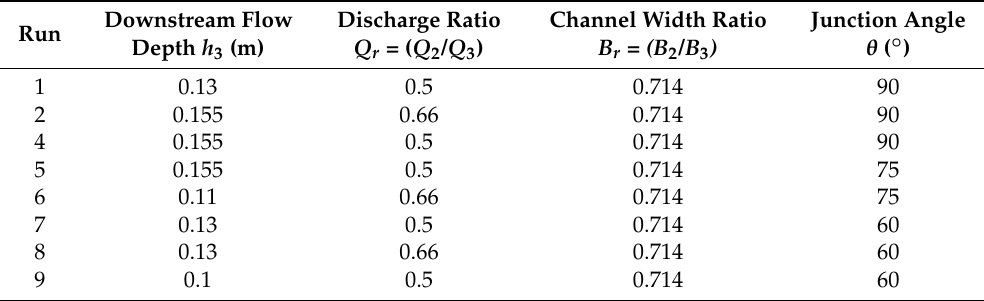
Table 3. Simulations carried out for a comparison with the physical model.